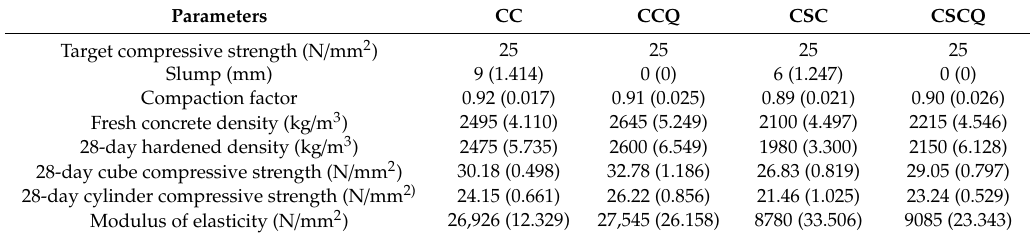
Table 3. Fresh and hardened properties of di ff erent concrete mixes